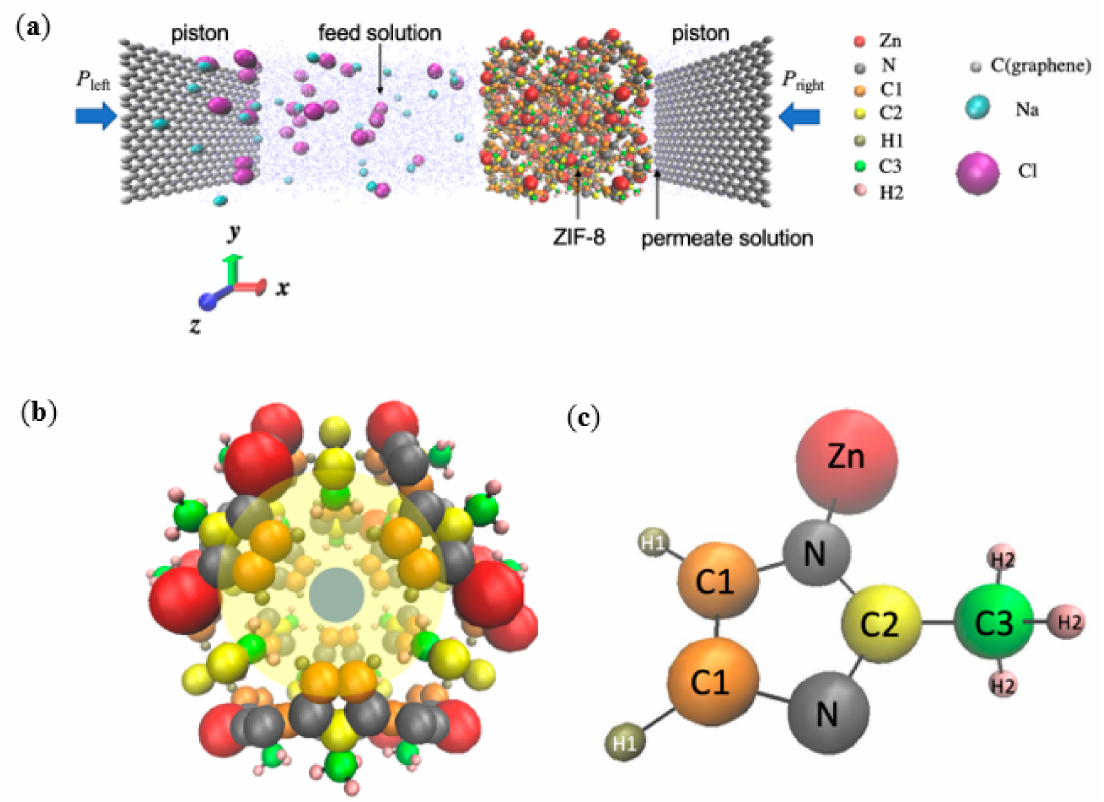
Figure 1. ( a ) Schematic of the simulation system for the pristine ZIF-8 membrane. The feed solution (Na + , Cl − , and water) and the permeate reservoir (pure water) are separated by a ZIF-8 membrane. Two graphene pistons at the two ends of the chambers are subjected to hydraulic pressures P left and P right , respectively. ( b ) A representative unit cell of the ZIF-8 framework. The blue circle highlights an aperture, and the yellow circle highlights a cage. ( c ) The 2-methylimidazole structure exhibited by ZIF-8, in which the atoms are represented by the following color codes: Zn: red, N: grey, C1: orange, C2: yellow, H1: tan, C3: green, H2: pink, H (water) and O (water): blue, Na + : cyan, Cl − : purple, and C (graphene):